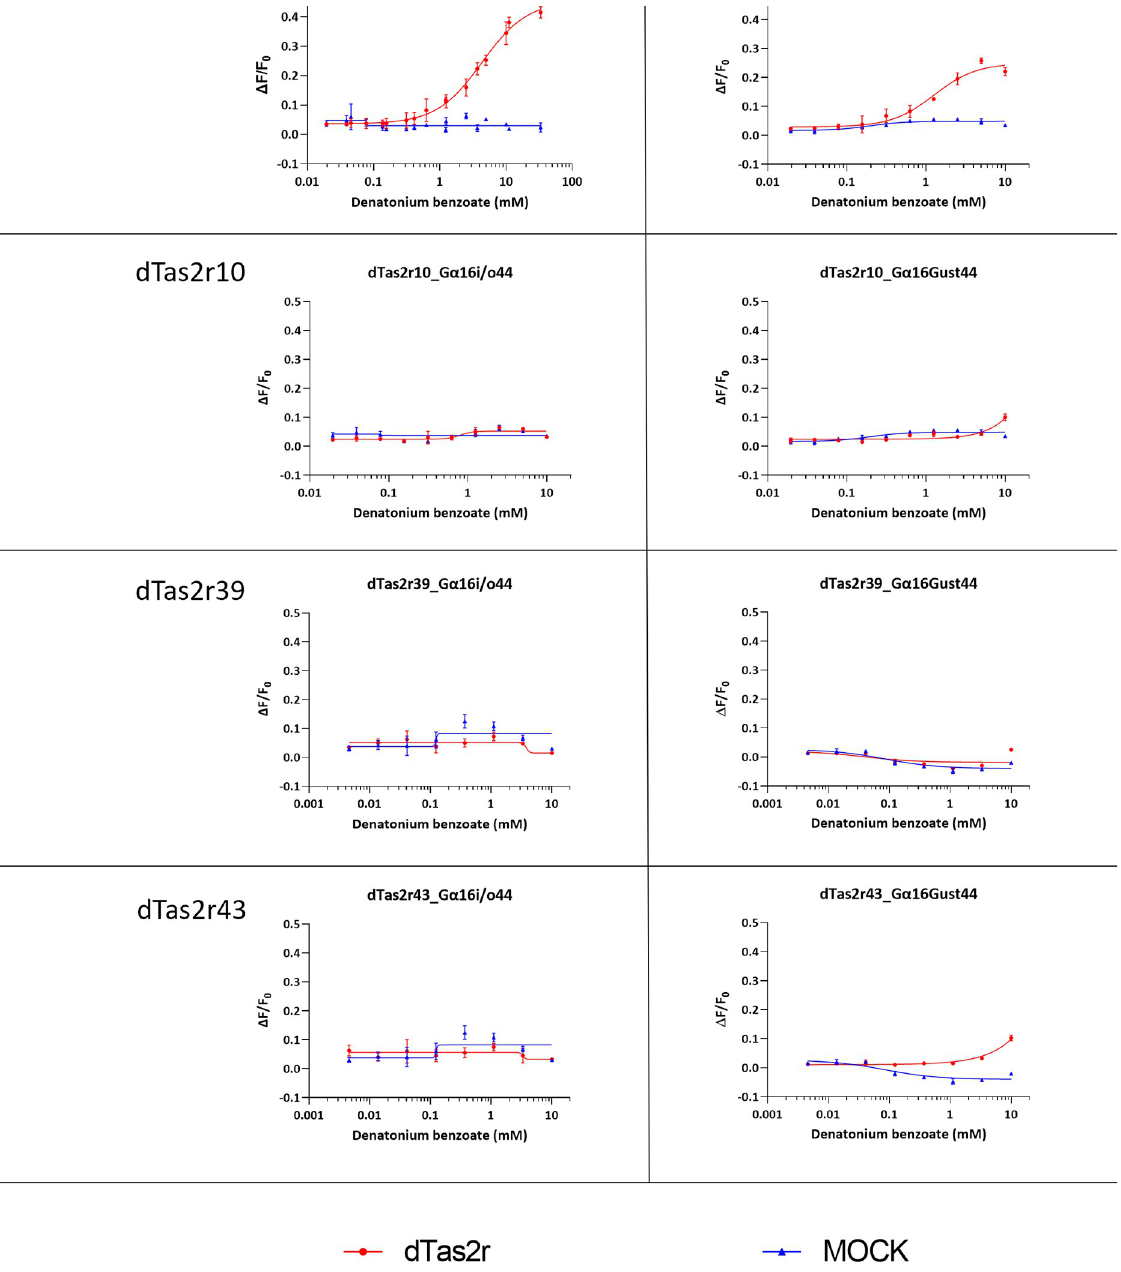
Fig 4. Testing of DB with orthologous receptors in dogs and humans with two different recombinant cell lines. In addition to the G α 16i/ o44 cell line, the G α 16/gust44 cell line was used. Results were similar with concentration-dependent responses only obtained with dTas2r4. When using the G α 16/gust44 cell line, small responses were observed with the highest concentration of DB only (10mM) for dTas2r10 and dTas2r43. These responses were significant (Student’s t-test, p < 0.001). Compound concentration is plotted on a log scale on the x-axis, the y-axis shows the maximum change in fluorescence divided by the baseline fluorescence before compound injection ( Δ F/F 0 ). Data for dTas2r4 is taken from the confirmatory screening and thus appears in S2 Fig